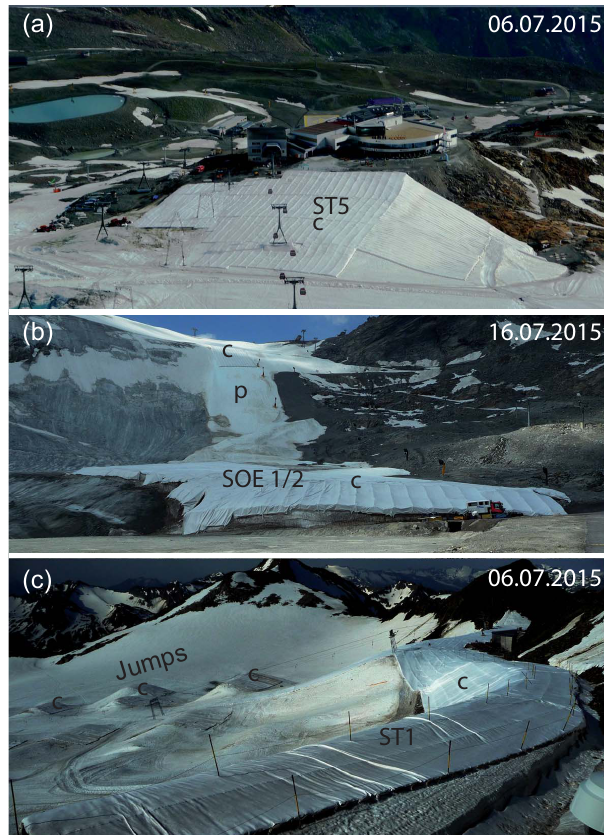
Figure 2. Mass balance management at profiles ST5 ( a , Stubai glacier ski resort; for hillshade and thickness change see Fig. 3), SOE1/2 ( b , Sölden ski resort), and ST1 ( c , Stubai Glacier ski resort) with applied measures: “c” indicates covers; “p” indicates snow pro-